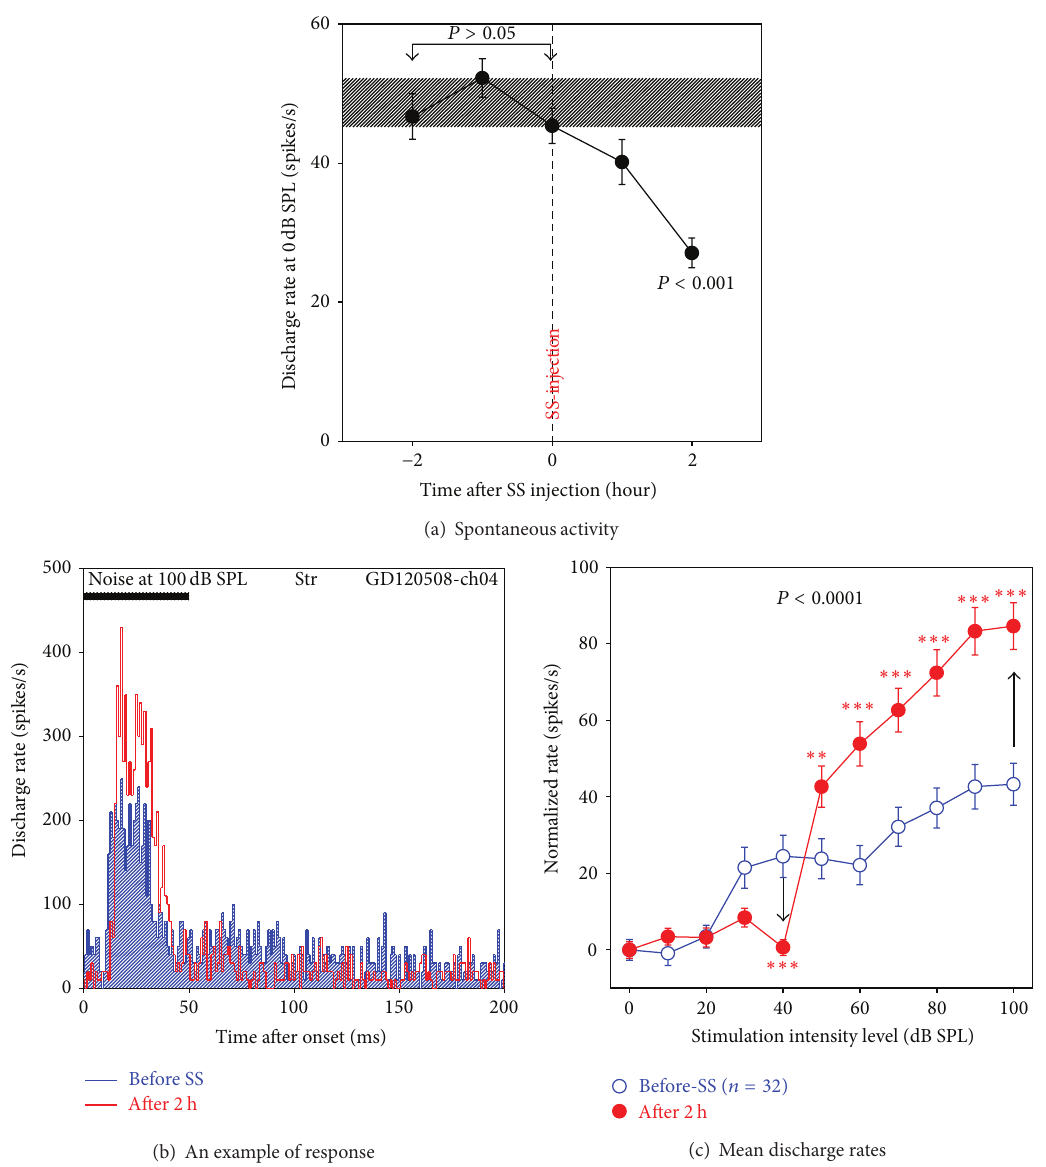
Figure 5: The SS effects on unit activity of neurons in the Str. (a) Mean spontaneous discharge rates ( 𝑛 = 32 ) as a function of time showing significant decrease after SS injection ( 𝑃 < 0.001 ). (b) An example of peristimulus time histograms (PSTH) obtained before SS (blue) and after SS (red), showing SS-induced increase of discharge rate. (c) Averaged discharge rates of neurons in the Str ( 𝑛 = 32 ) in a time window of 100ms, showing a similar effect of SS injection as the LFP recorded in the nucleus. The discharge rates of each neuron were normalized to that at 0 dB SPL. Acoustic stimulation: 50 ms noise burst; treatment: SS (250mg/kg, i.p.); the vertical bars are SEs; the arrows indicate increase and decrease of unit activity; ∗∗∗ 𝑃 < 0.001 ; ∗∗ 𝑃 < 0.01